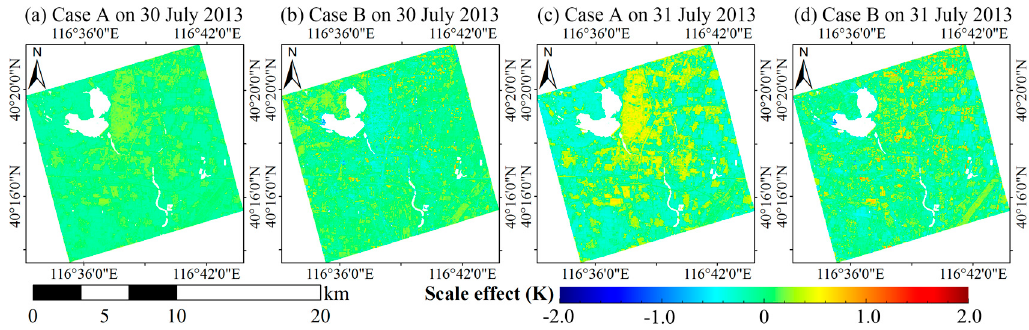
Figure 12. ( a – d ) The estimated scale effects in downscaling the Tiangong-1simulated LST and TIRS LST with GRM in Case A and Case B.